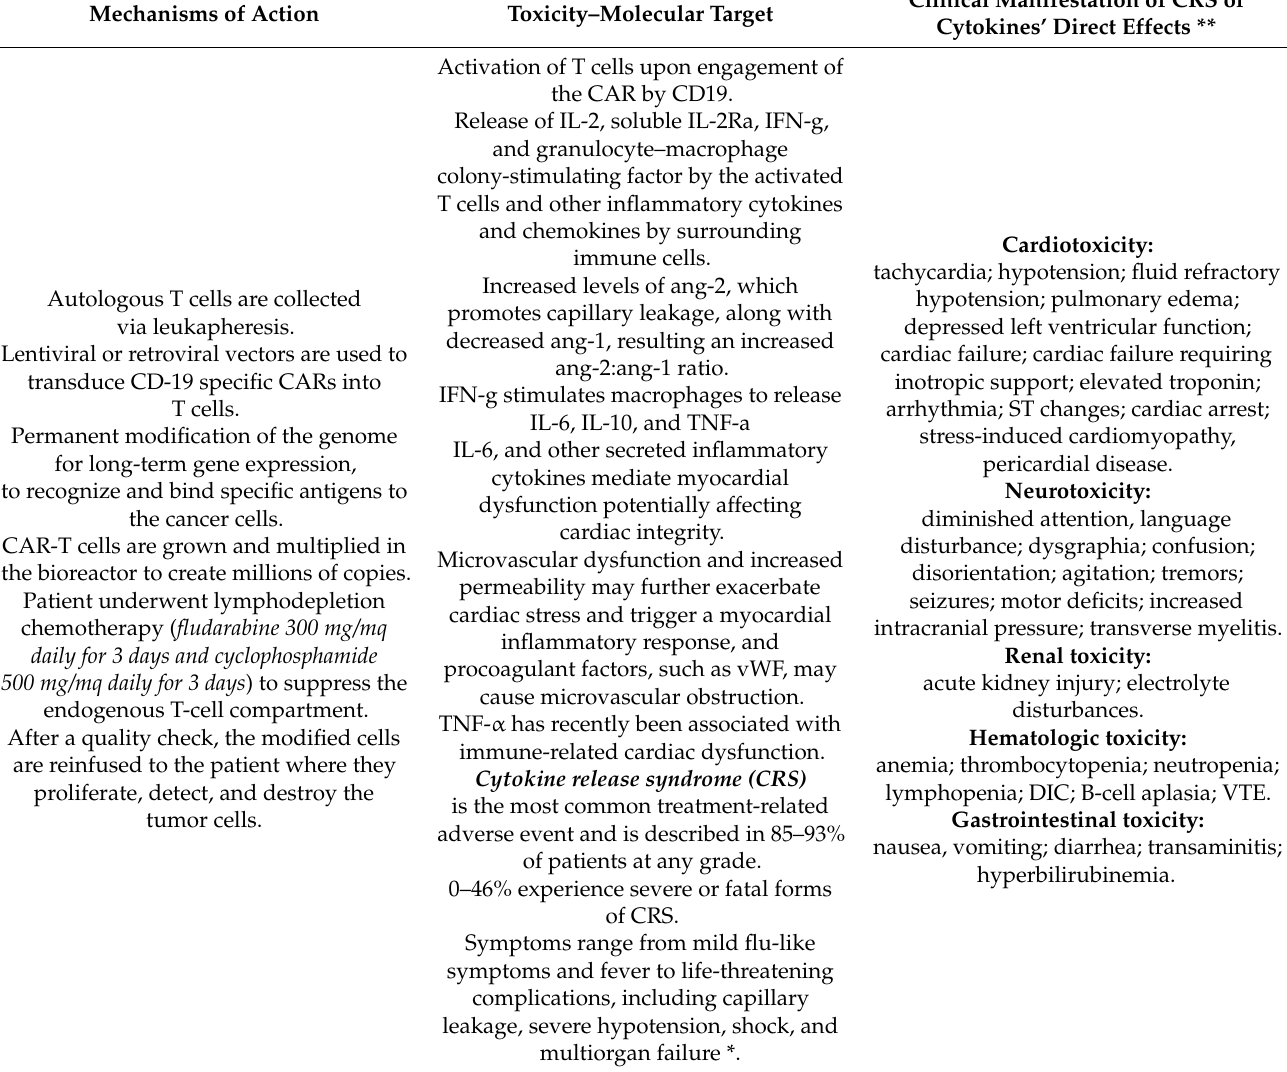
Table 2. Chimeric antigen receptor T-Cell therapy: from molecular target to clinical manifestation of toxicity